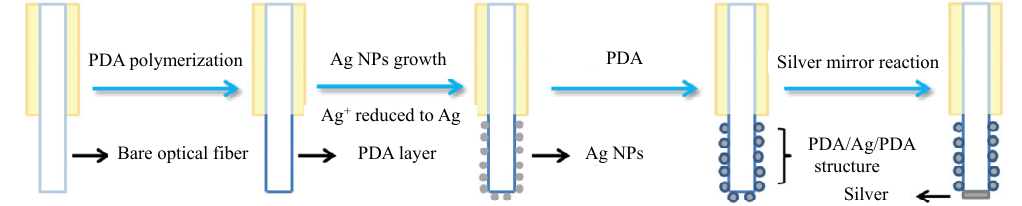
Fig. 1 Schematic of the fabrication process of PDA/Ag/PDA-based LSPR sensor in this